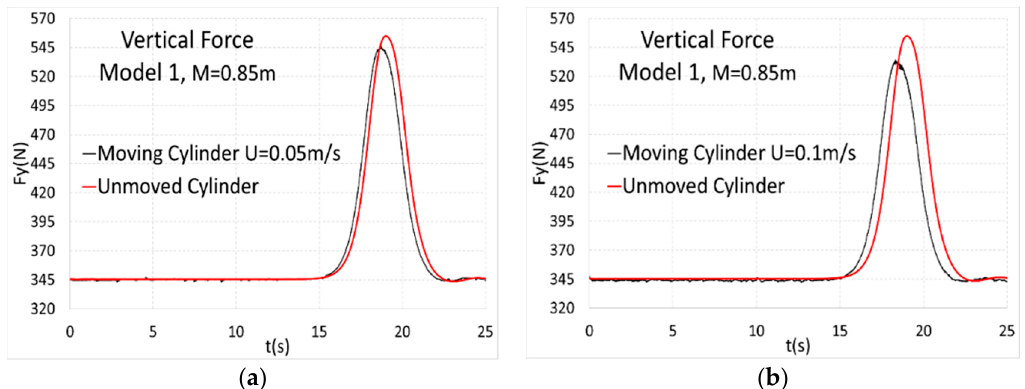
Figure 14. The time variation of vertical forces for model 1. ( a ) The comparison between the unmoved cylinder (red line) and the moving cylinder at U c = 0.05 m/s. ( b ) The comparison between the unmoved cylinder (red line) and the moving cylinder at U c = 0.1 m/s.